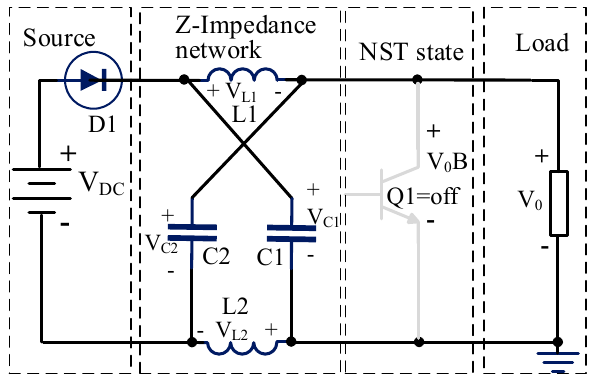
Figure 6. Electrical diagram of Z-source converter in the Non-Shoot-Through (NST) state. The D1 diode is directly polarized, so the L 1 and L 2 inductors together with the V DC power supply charge the C 1 and C 2 capacitors: